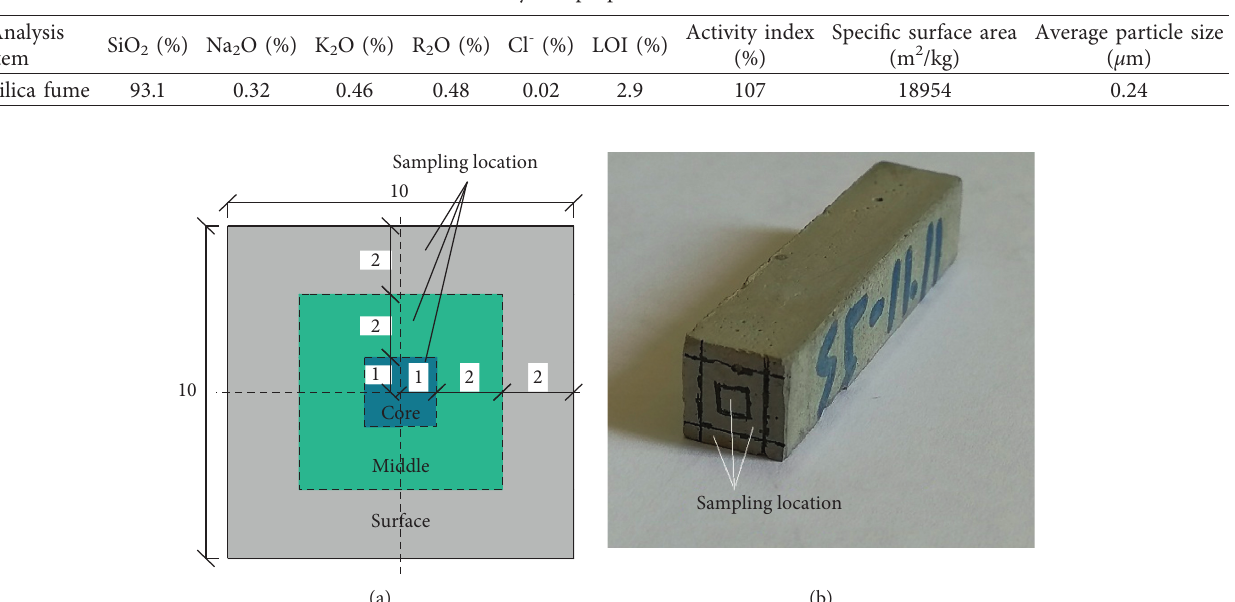
Table 2: Physical properties of silica